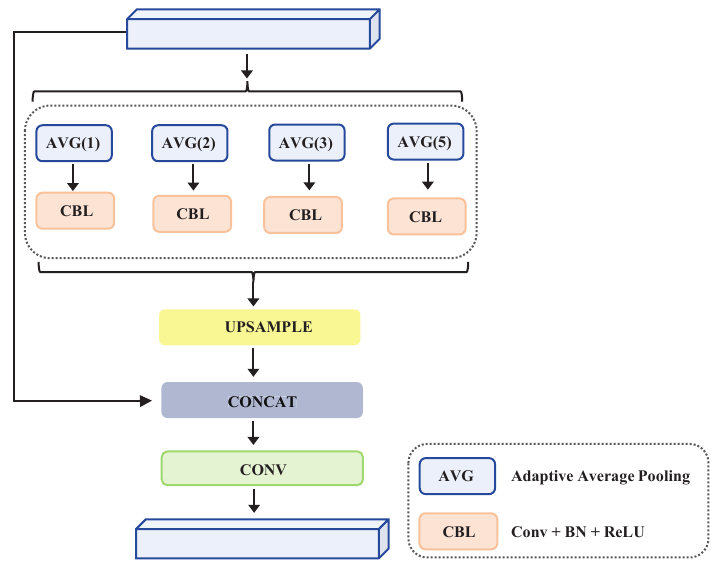
Figure 3. Pyramidal aggregation module